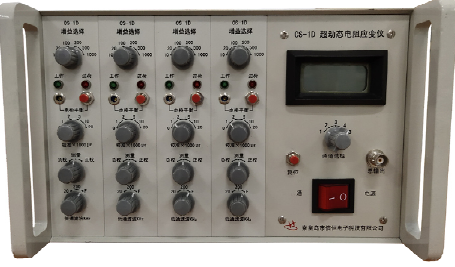
Figure 3. Dynamic resistance strainometer.